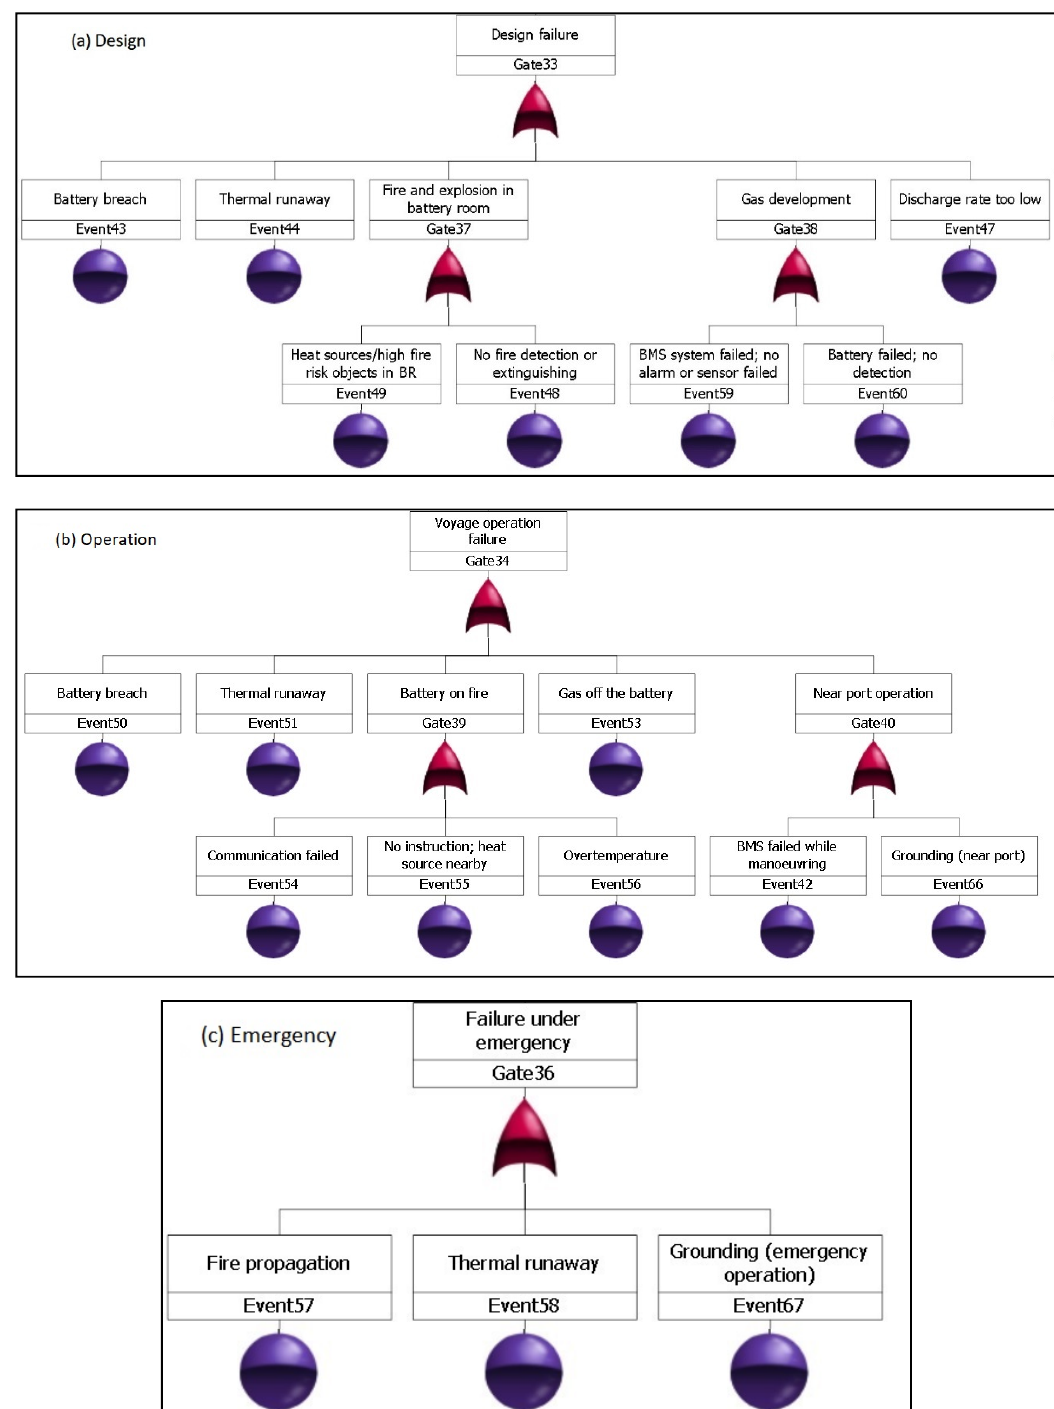
Figure 9. Fault tree analysis on hazard associate with grounding.